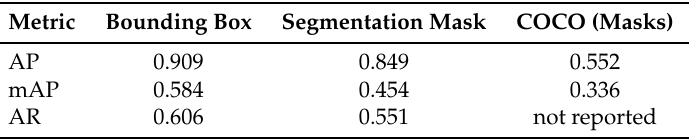
Table 3. Evaluation metrics ‘averaged precision score’ (AP), ‘mean averaged precision score’ (mAP) and ‘averaged recall score’ (AR) of the fully trained model for detection of bounding boxes and segmentation masks. The third column contains the performance of the Mask R-CNN model with ResNet50-FPN backbone on the COCO